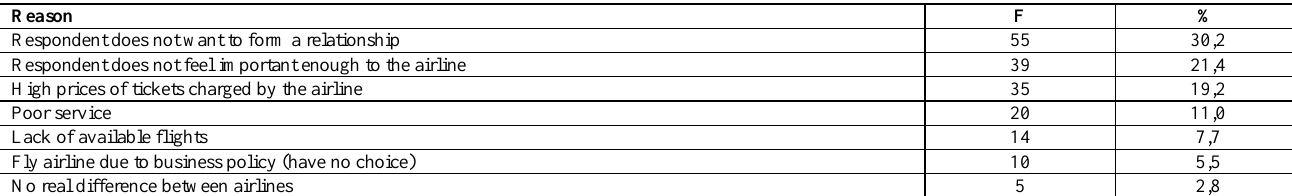
Table 4: Respondents’ satisfaction with the airlines and whether they have formed a long-term relationship with the airlines Whether long-term relationship was formed Have formed a relationship Have not formed a relationship Satisfied Satisfaction with airlines